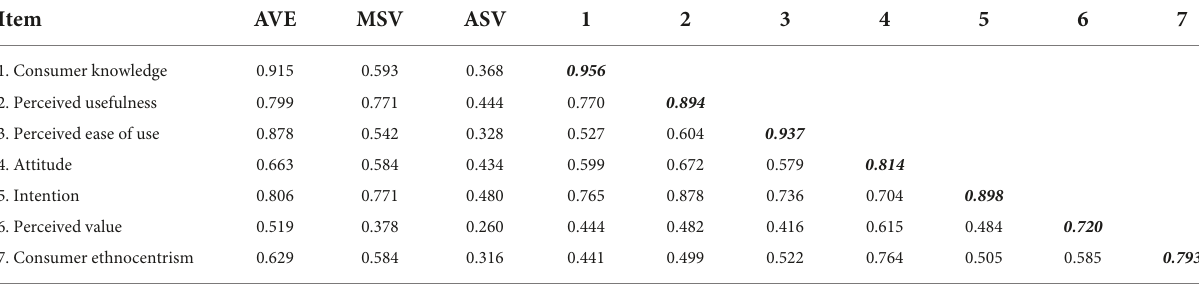
TABLE 4 Discriminate validity for measurement model (HTMT test).